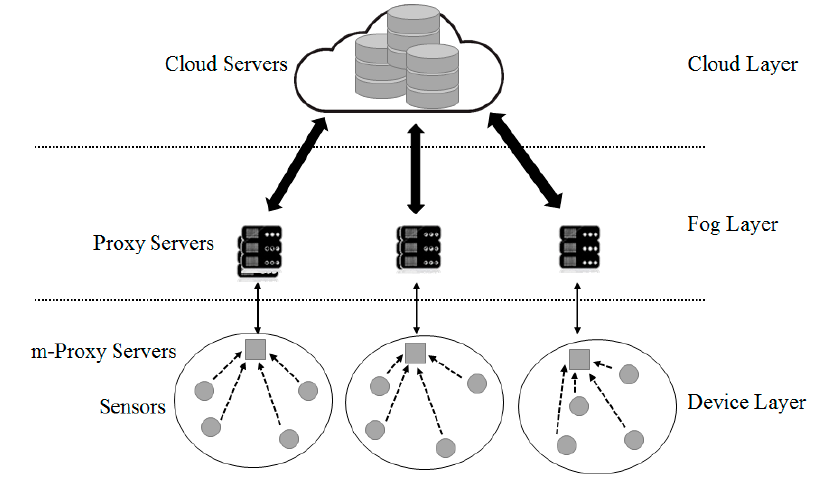
Figure 8. Proposed System Architecture.